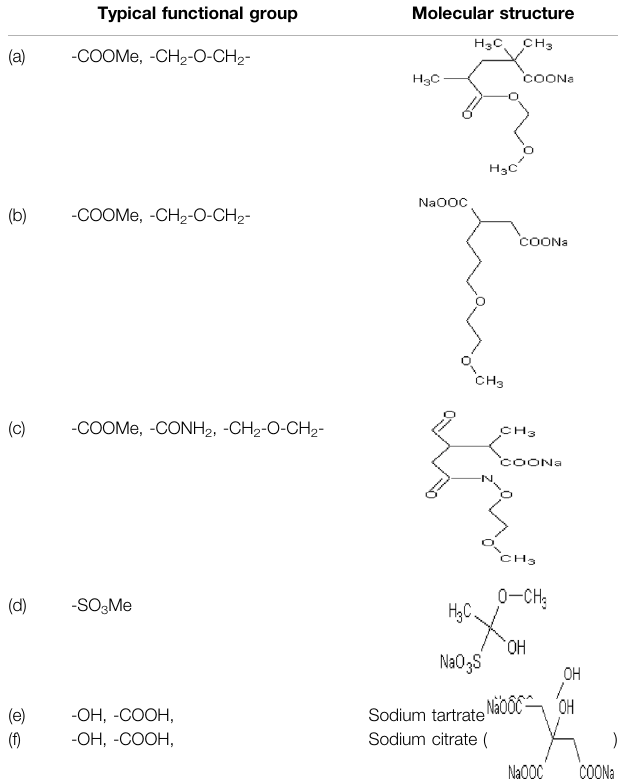
TABLE 2 | Typical functionalgroups and molecular structures adopted in the text.